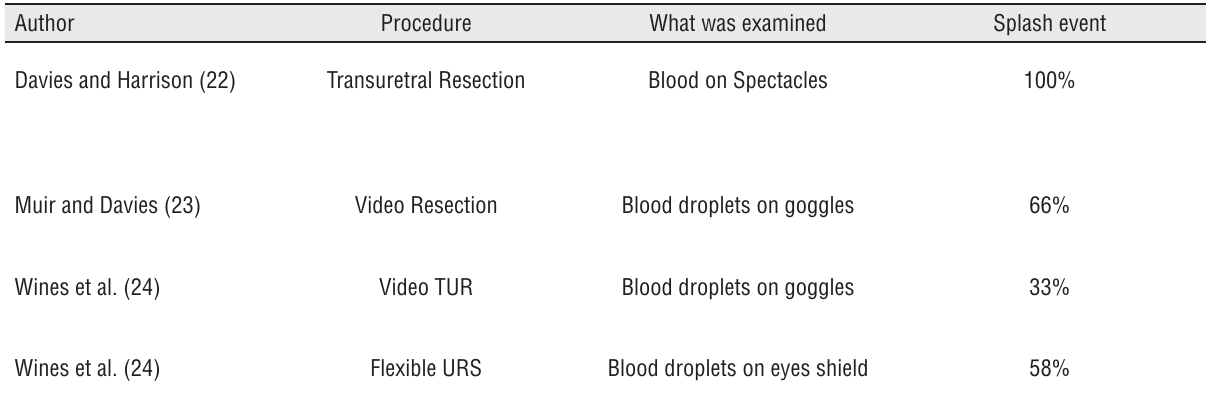
Table 1 - Splashing blood events on eye